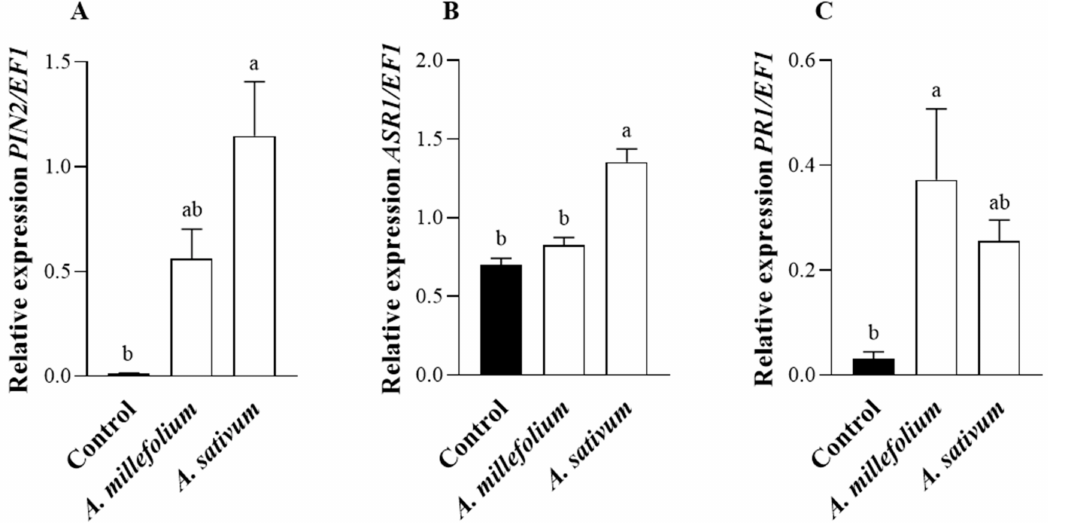
Figure 4. Transcriptional response of the defensive marker genes PIN2 ( A ), ASR1 ( B ), and PR1 ( C ) of JA, ABA, SA, and signaling pathways, respectively, in tomato plants sprayed or not with Achillea millefolium or Allium sativum essential oils. The analysis was conducted 24 h after the spray. The means of four plants in each treatment ± SE are shown. Bars marked with different lower-case letters are significantly different (Tukey’s test; p ≤